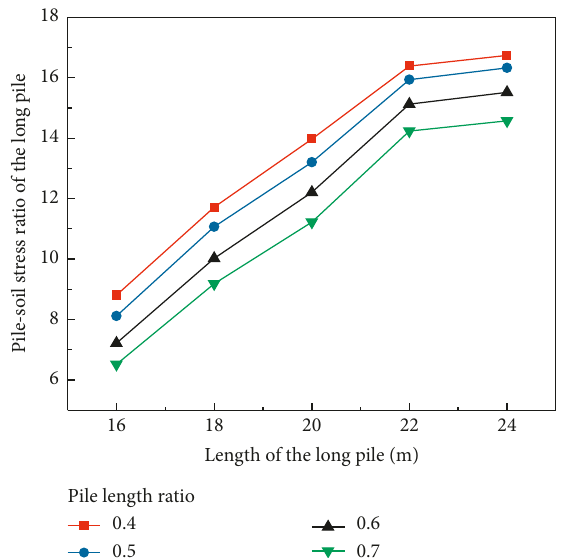
Figure 15: Influence of pile length on long pile stress.